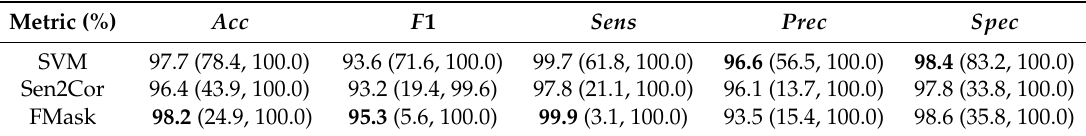
Table 4. The median and 95% confidence intervals for all adopted metrics are reported for all the compared methods. MAJA was excluded from this comparison as the longitudinal series of images needed for its training are not available. Best results are in bold.